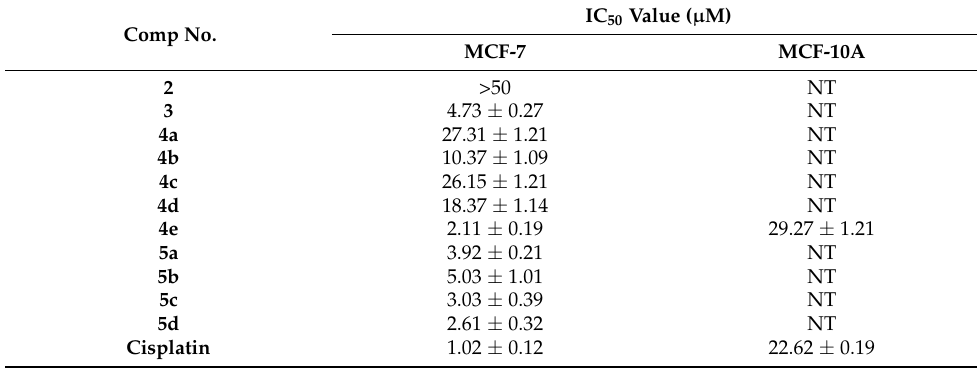
Table 1. Calculated IC 50 for compounds 2–5d against breast cancer cell line MCF-7 cells. Data expressed as the mean SE from the dose–response curve of at least three experiments. Comp